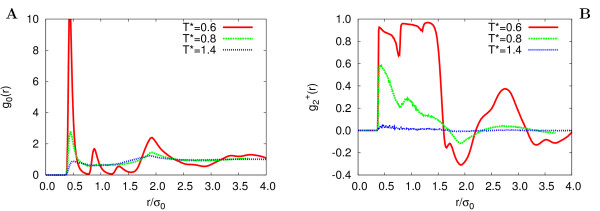
HT-T, Correlation functions. Radial correlation function g0(r) (A) and second rank anisotropy g2+(r)
 MathType@MTEF@5@5@+=feaafiart1ev1aaatCvAUfKttLearuWrP9MDH5MBPbIqV92AaeXatLxBI9gBaebbnrfifHhDYfgasaacH8akY=wiFfYdH8Gipec8Eeeu0xXdbba9frFj0=OqFfea0dXdd9vqai=hGuQ8kuc9pgc9s8qqaq=dirpe0xb9q8qiLsFr0=vr0=vr0dc8meaabaqaciaacaGaaeqabaqabeGadaaakeaacqWGNbWzdaqhaaWcbaGaeGOmaidabaGaey4kaScaaOGaeiikaGIaemOCaiNaeiykaKcaaa@332D@ (B) from MC simulations of system Q1 at T* = 0.6 (red continuous line), 0.8 (green dotted line), 1.4 (blue dashed line).